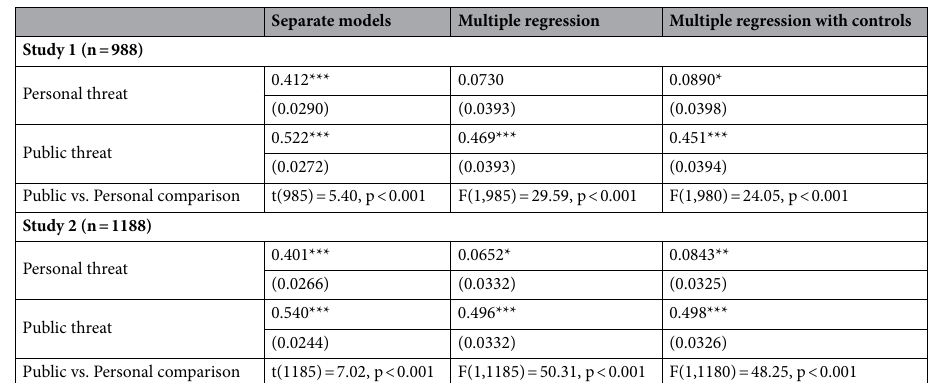
Table 3. Associations between threat variables and prevention intentions in Studies 1 and 2. We report results from regressions predicting prevention intentions as a function of our threat variables. Shown are results from (i) a set of separate regression models for each threat variable (Column 1) and (ii) multiple regression models using both threat variables (Columns 2–3), for Study 1 (top rows) and Study 2 (bottom rows). We show results from multiple regression models both with and without controls for age, gender, education (coded here and in all analyses as a college degree dummy), income, and political party affiliation. All coefficients are standardized coefficients, with standard errors for each coefficient in parentheses. For each model, we also report results from a test comparing the public versus personal threat coefficient. Standard errors in